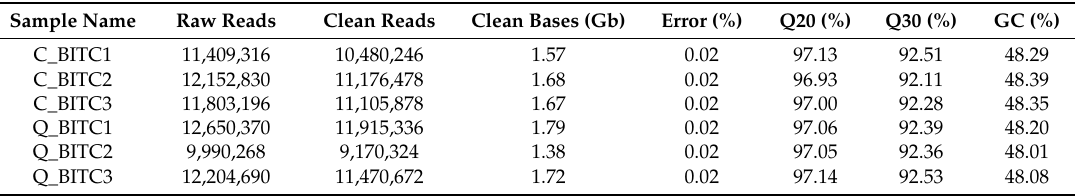
Table 2. Summary of the RNA sequencing data.